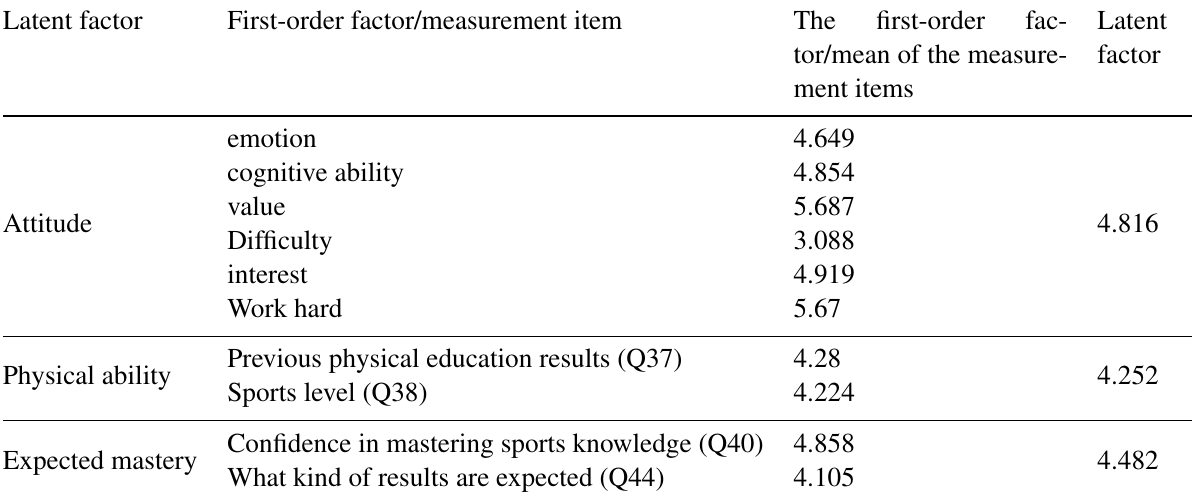
Table 2 Descriptive analysis of potential